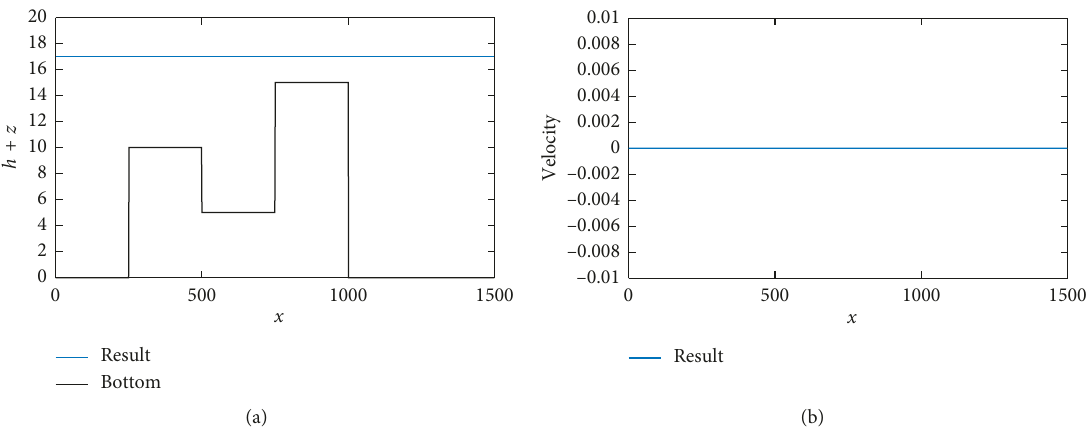
Figure 4: Water depth (a) and velocity (b) at final time